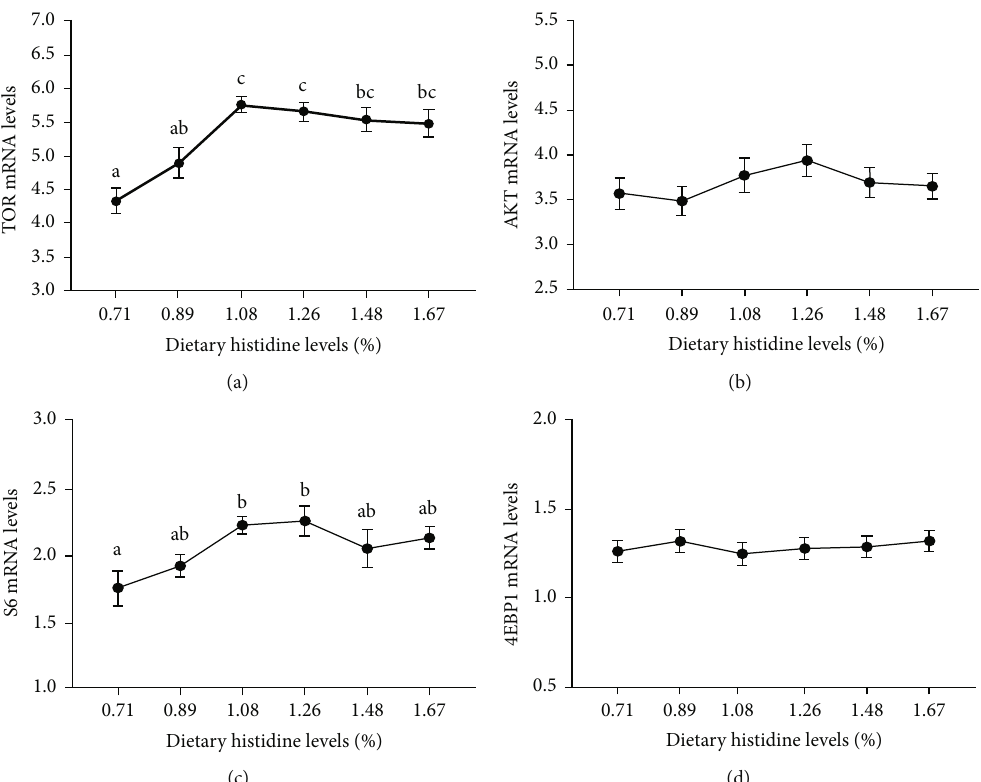
Figure 5: The relative expressions of TOR signaling pathway in liver of juvenile largemouth bass fed with di ff erent levels of dietary histidine. Data are expressed as means with S.E.M.; value with di ff erent superscripts are signi fi cantly di ff erent ( P < 0 : 05